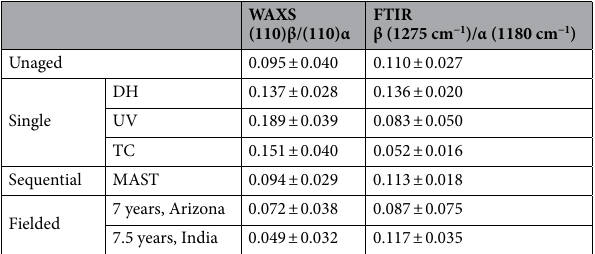
Table 4. Relative peak intensity ratio of PVDF β- to α-phase from two different phase identification methods, WAXS and FTIR, in PVDF-B backsheets aged with different test conditions.